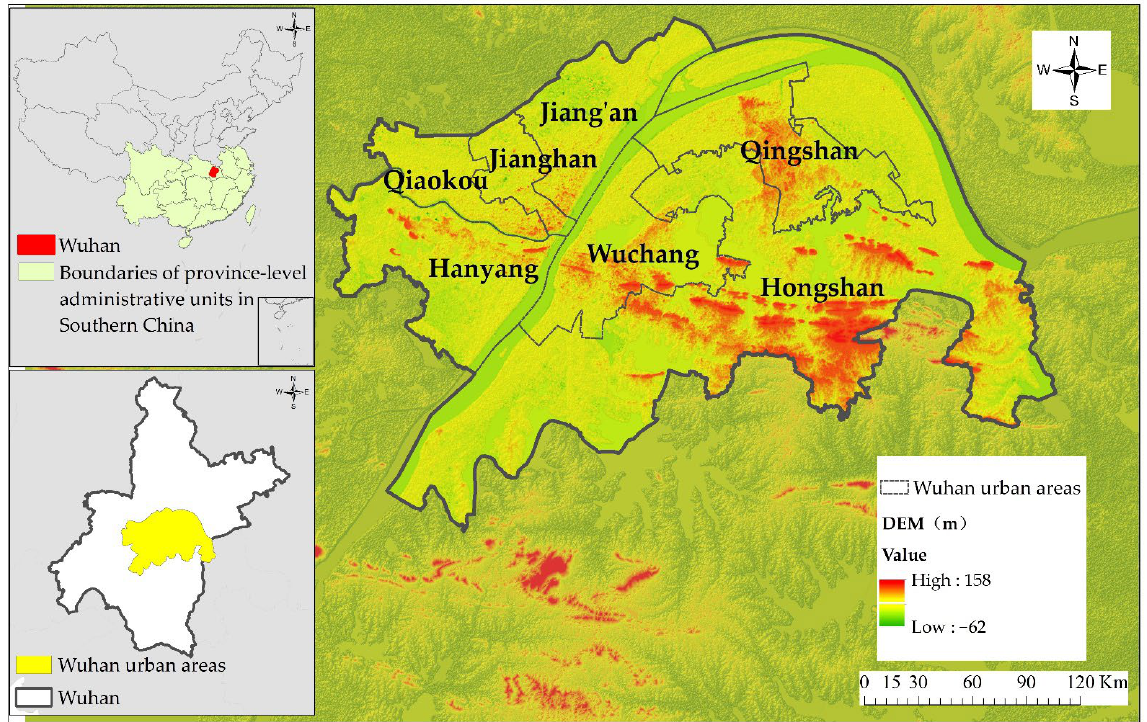
Figure 1. Location of the study